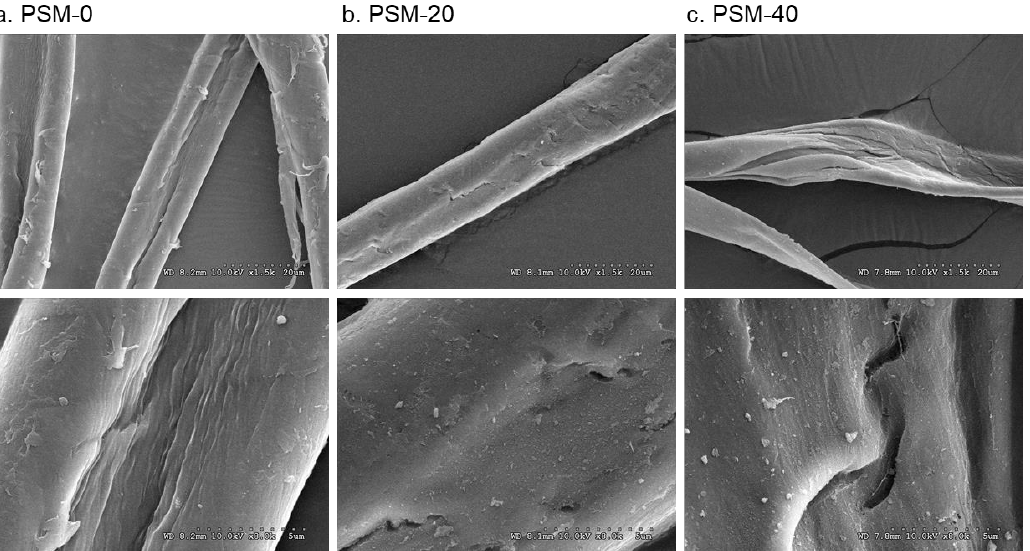
Figure 4. Effect of plasma pretreatment on the surface morphology of cotton fibers. SEM micrographs of ( a ) control cotton fibers (PSM-0) and plasma surface modified fibers for ( b ) 20 min (PSM-20) and ( c ) 40 min (PSM-40). (Magnification: × 1.5K (top) and × 8K (bottom)).